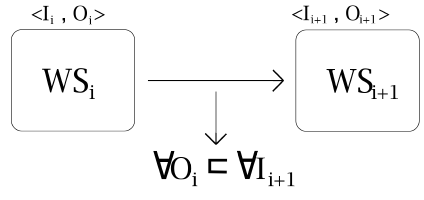
Figure 3. Web service assembly structure.